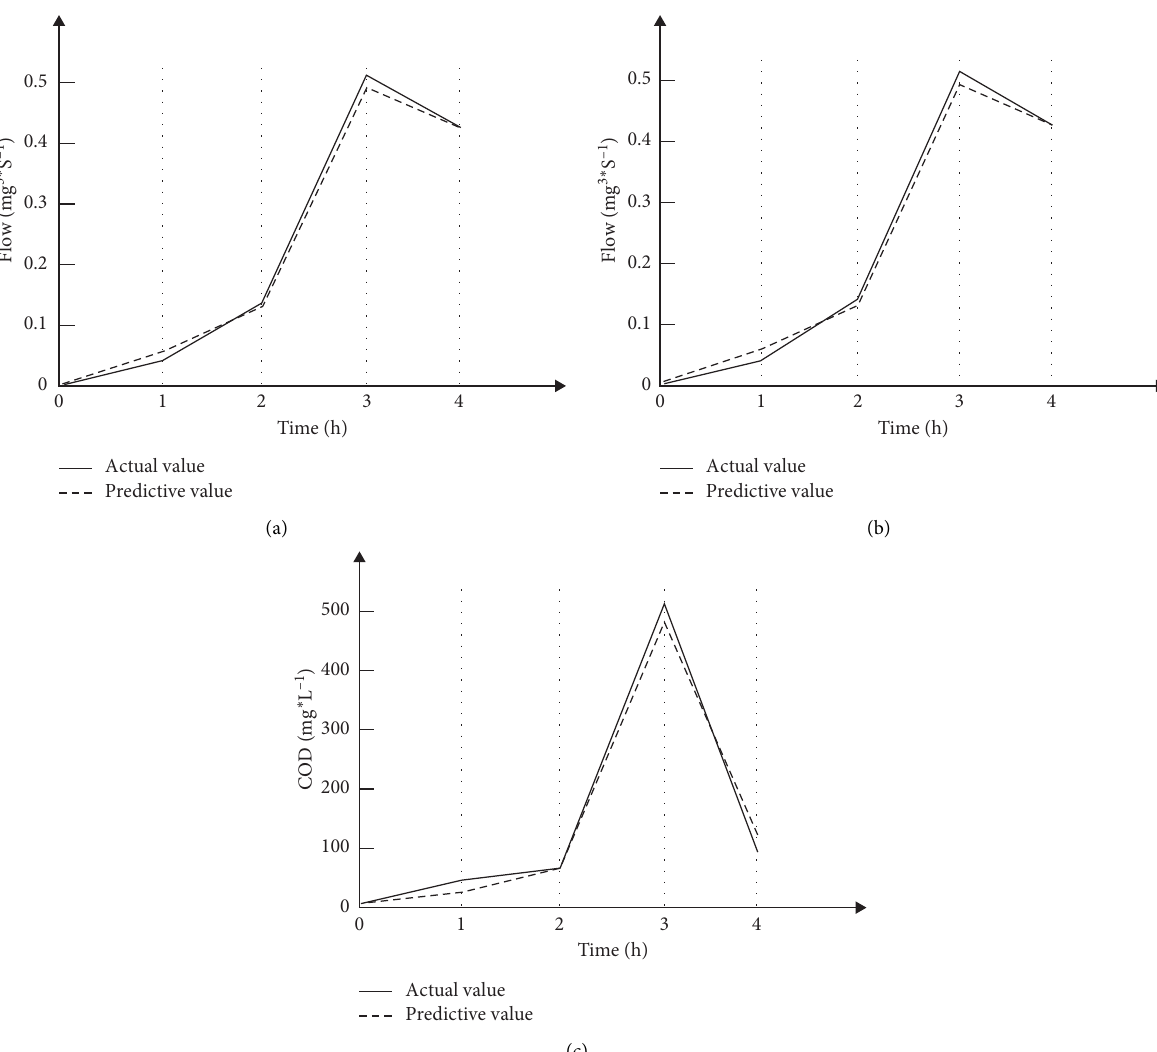
Figure 3: Results of rainfall runoff pollution prediction based on grey neural network algorithm. (a) Predicted flow value and fitting with actual value, (b) predicted SS concentration value and fitting with actual value, (c) predicted COD concentration value and fitting with actual value.